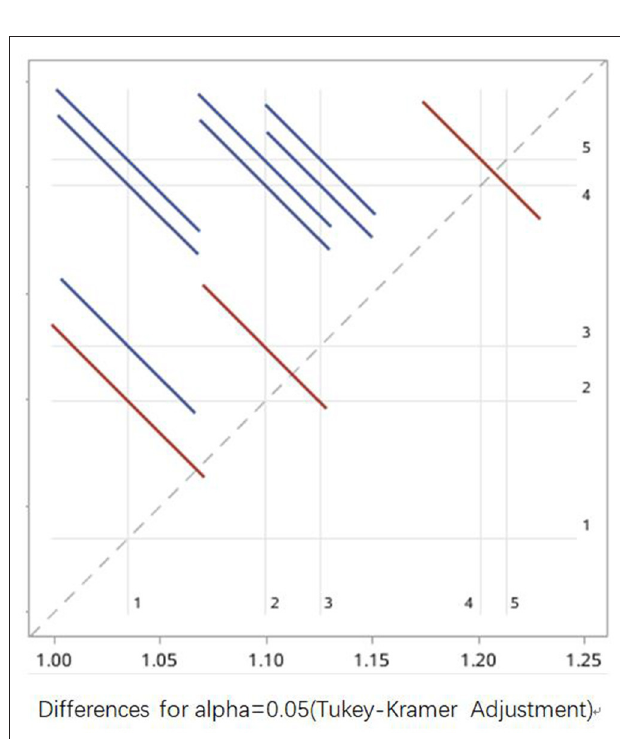
FIGURE 5 | Statistical difference between Vitamin A levels of children from households of different income. 1 ≤ 500 CNY, 2 = 500–999 CNY, 3 = 1,000–2,999 CNY, 4 = 3,000–4,999 CNY, 5 ≥ 5,000 CNY. The blue lines indicate a significant difference between the paired groups, and the red lines indicate no differences between the paired groups.